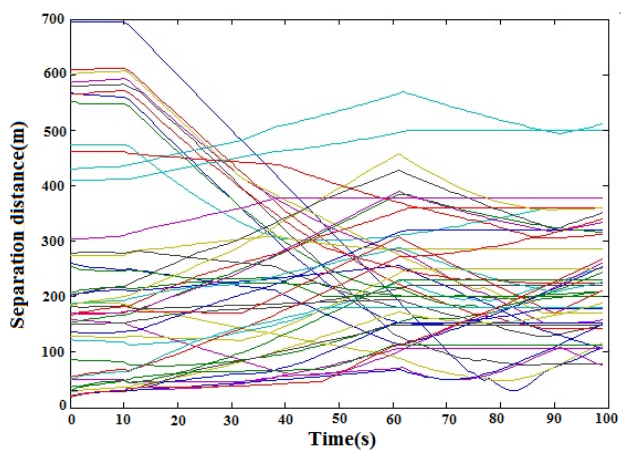
Figure 19. Case 3: Cooperative collision avoidance against temporary communication failure (unhealthy situation): Separation distance along horizontal direction.